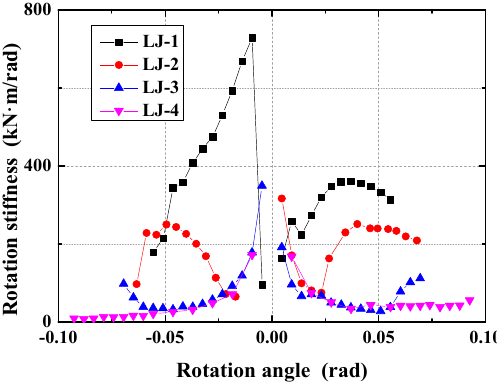
Figure 23. Stiffness degradation curve.